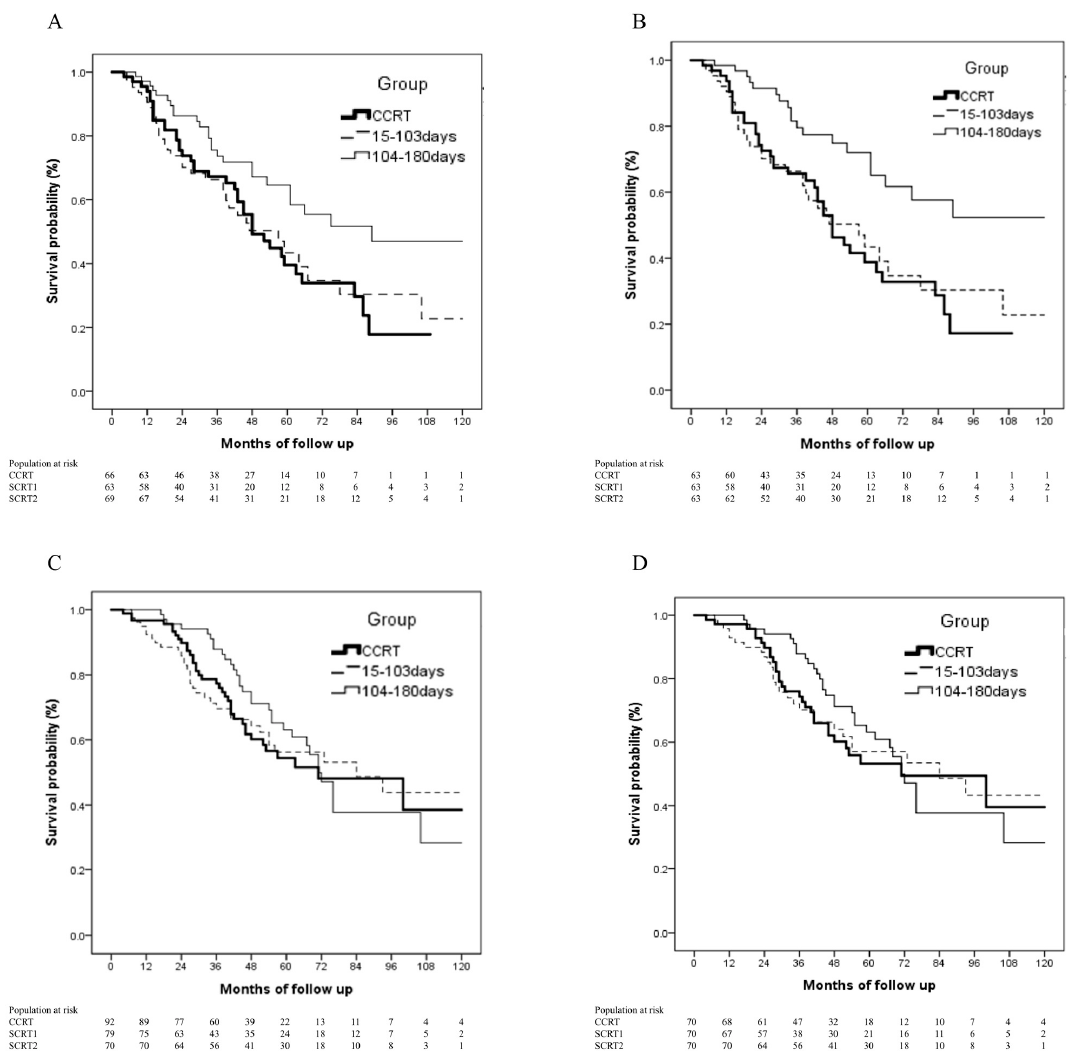
Figure 4. Kaplan–Meier OS curves in patients treated according to the three PORT schedules (CCRT, SCRT1 [15–103 days], SCRT2 [104–180 days]) in subgroups stratified by age. ( A ) Age >60 years, before PSM, log-rank test, p = 0.024; ( B ) Age >60 years, after PSM, log-rank test, p = 0.002; ( C ) Age ≤ 60 years, before PSM, log-rank test, p = 0.856; ( D ) Age ≤ 60 years, after PSM, log-rank test, p = 0.871. Abbreviations: CCRT: concurrent chemoradiation; OS: overall survival; PORT: postoperative radiotherapy; PSM: propensity score matching; SCRT1: sequential chemoradiation group 1; SCRT2: sequential chemora-